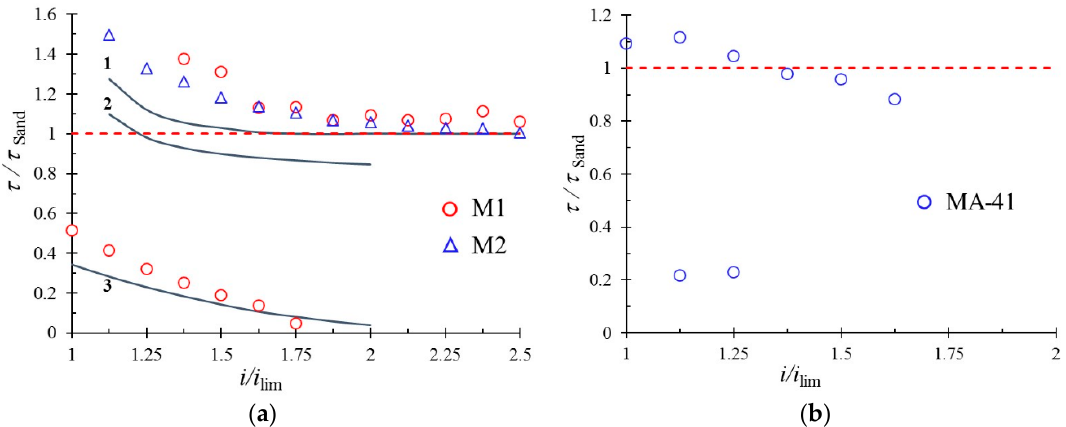
Figure 18. Dependence of the τ / τ Sand ratio on the i / i lim ratio for the M1 (the conductive surface area fraction γ = 0.077, red circles) and M2 ( γ = 0.318, triangles) membranes (both are lab-made on the basis of track-etched membranes) ( a ) and for a anion-exchange heterogeneous MA-41 membrane ( γ = 0.2) ( b ). The horizontal dashed line shows the τ Sand value. The solid curves present the results of calculation of τ using the 3D model [303]: curve 1 relates to a hypothetical homogeneous membrane, curves 2 and 3, to the M1 and M2 heterogeneous membranes, respectively. Reproduced with permission from [314], Elsevier, 2018.